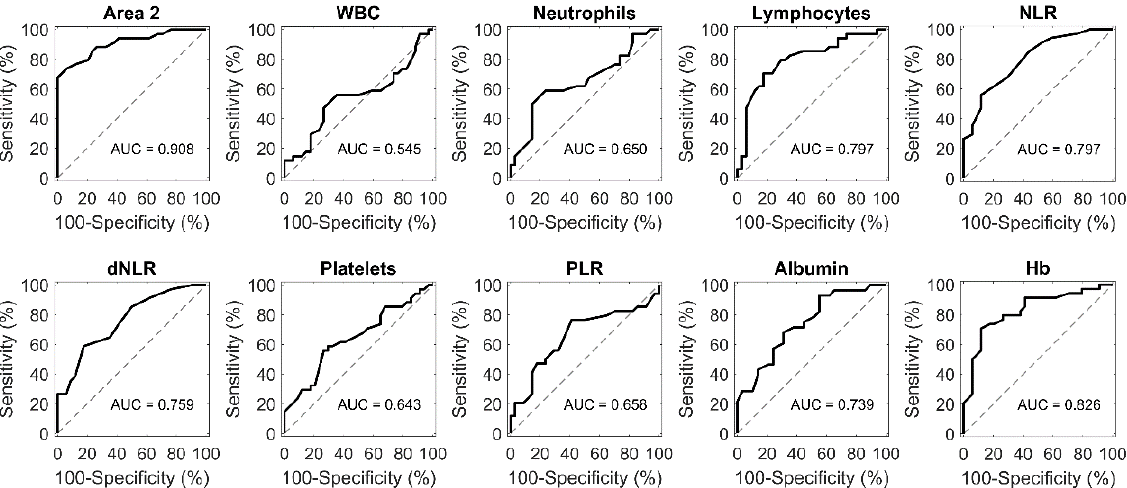
Figure 3. Receiving operative curve (ROC) curve and corresponding area under the curve (AUC) for each of the indicated parameters.